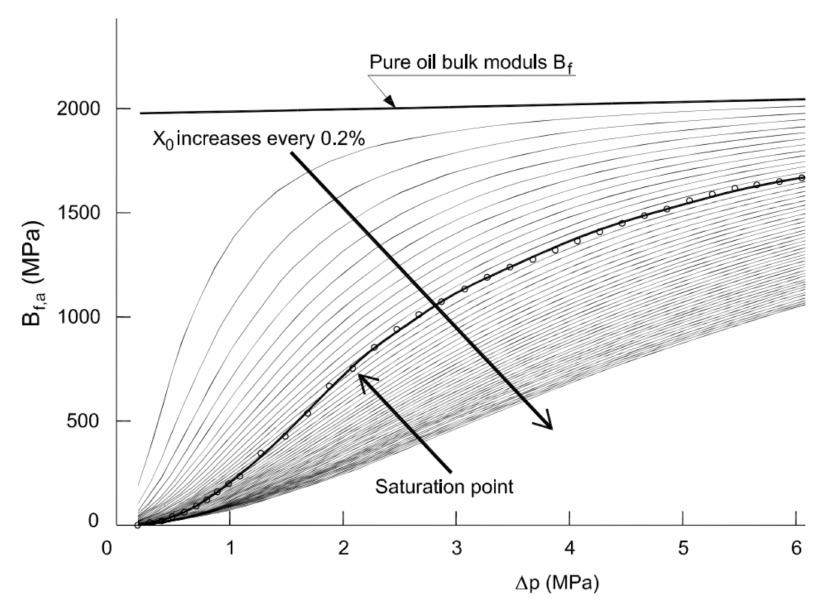
Figure 10. Comparison of the experimental results with a series of “compression-only” bulk modulus curves for an isothermal process [30].